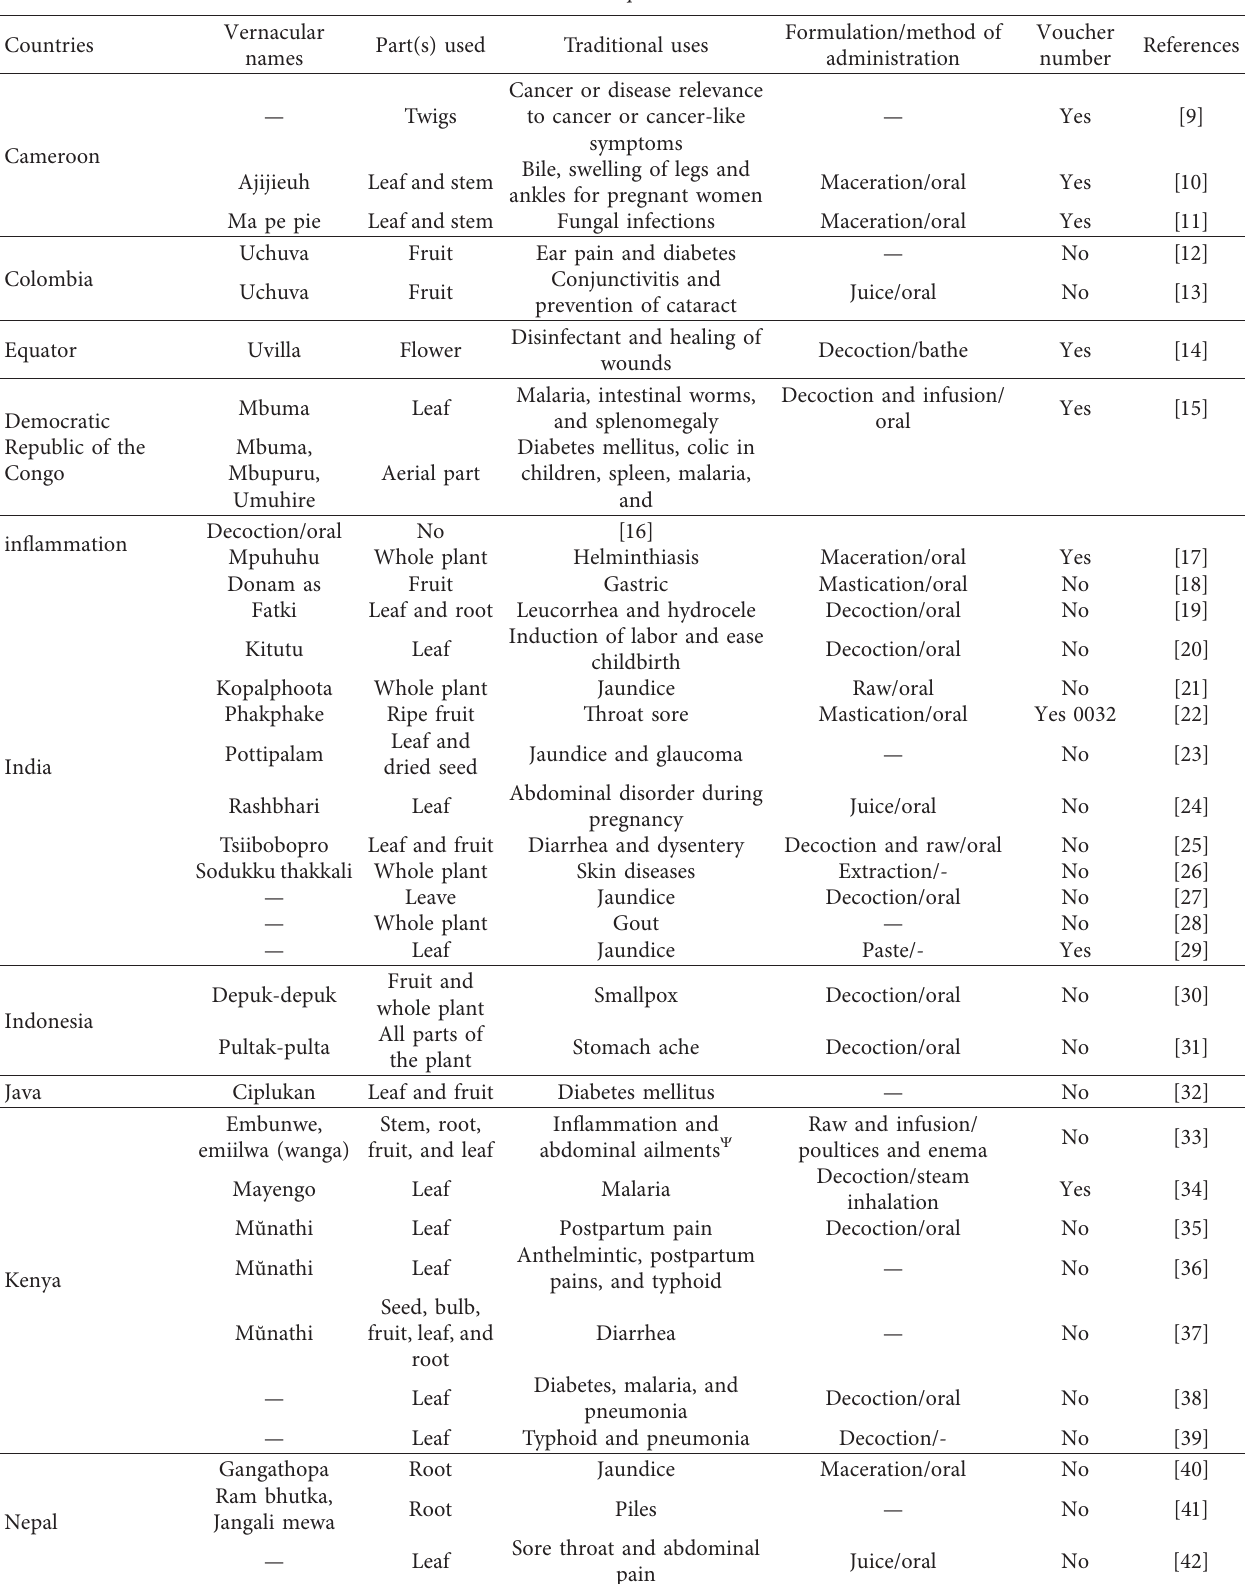
Table 1: Ethnomedicinal uses of P . peruviana L. in different